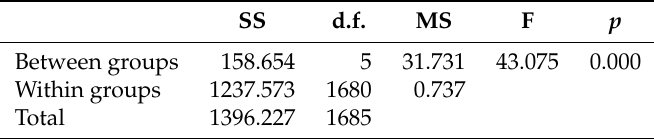
Table A3. One-way ANOVA between information